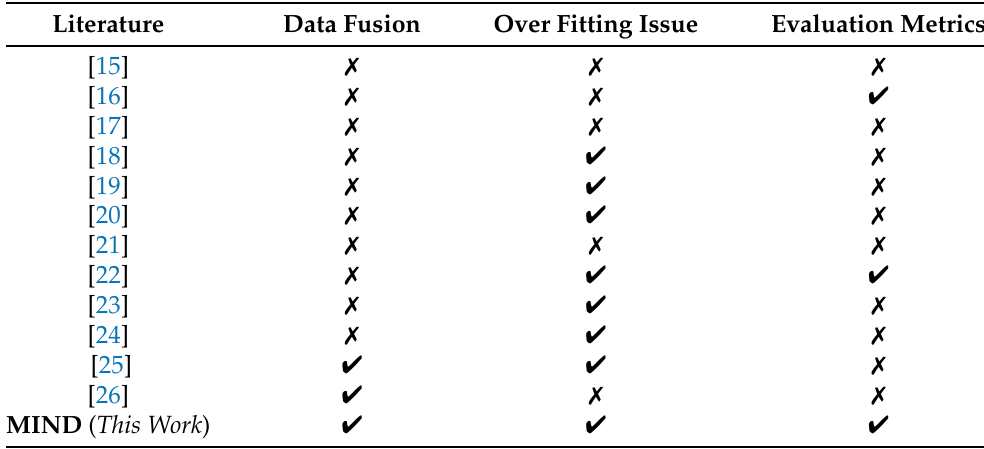
Table 1. Comparison with existing